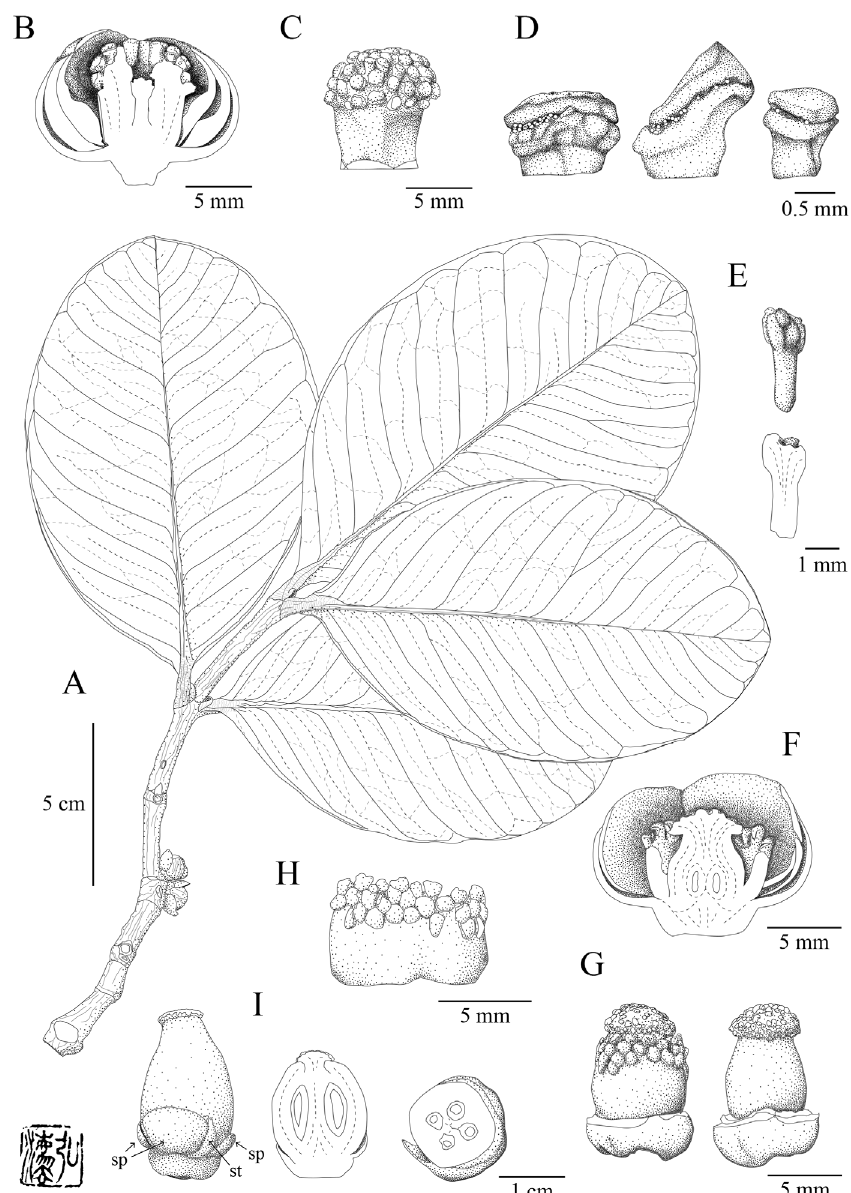
Figure 1. Garcinia hopii H.Toyama & V.S.Dang, sp. nov. A branch with pistillate flower B longitudinal section of staminate flower C lateral view of staminate flower, tepals removed D free part of stamens E lateral view (upper) and longitudinal section (lower) of pistillode F longitudinal section of pistillate flower G pistillate flower, tepals removed (left) and tepals and staminodes removed (right) H staminodes cut in half longitudinally I immature fruit (left) with sepals (sp) and staminodes (st) and its longitudinal (middle) and transverse (right) section. A, F–H from Toyama et al. V4475 (KYO) B–E from Toyama et al. V4476 (FU) I from Tran & Dang dv127 (FU). Drawn by H.